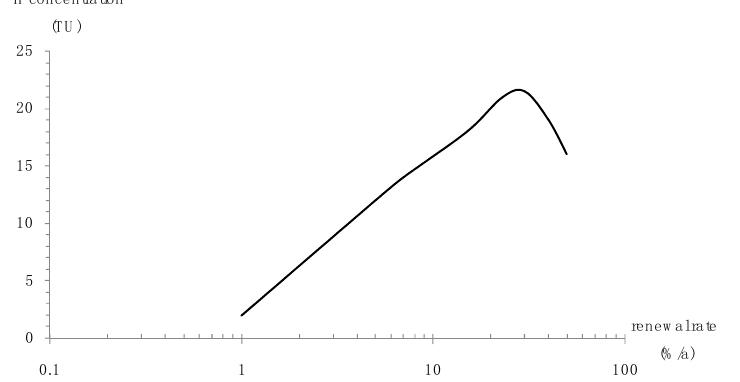
Figure 11. Relationship between groundwater tritium concentration and groundwater renewal rate.